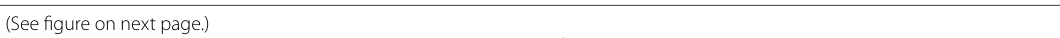
figure on next Fig. 1 A The number of leaves per plant, B subtending leaf area (cm − 2 ), C subtending leaf biomass (g), and D N content in the subtending leaf (%) of CCRI-69 and XLZ-30 in under control (2.5 mmol L − 1 ), and high (5 mmol L − 1 ) N conditions at 10, 25 and 40 days post-anthesis (DPA). Error bars · · with different small letters show a significant difference between genotypes under control and high N condition and capital letters in the brackets show significant difference among growth stages (10, 25, and 40 DPA) at P <